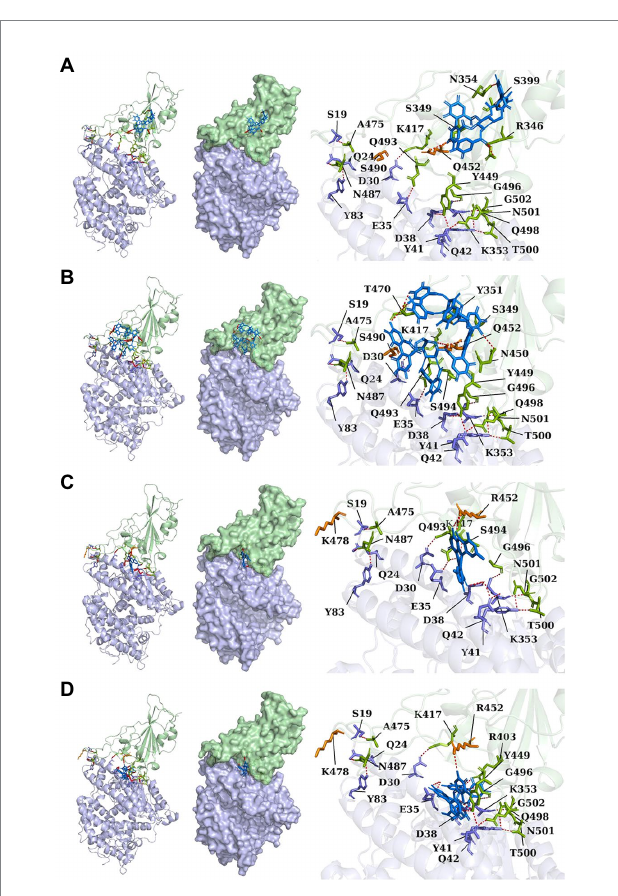
FIGURE 6 The cartoon, surface, and stick of Casuarictin (A) , Heterophylliin D (B) , Protohypericin (C) , and Glansrin B (D) binding to S-CTD dock with ACE2 receptor. The small molecule compounds were shown in marine. The S-CTD of lambda and delta was shown in pale green. The residue of S-CTD was shown in split-pea. The ACE2 receptor was shown in light blue. The residue of the ACE2 receptor was shown in the slate. The hydrogen bonds were shown in